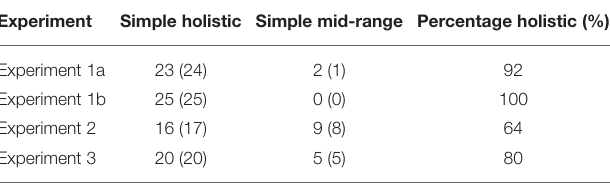
TABLE 2 | Number of participants (out of 25) classified as using the simple holistic vs. mid-range in their average estimations, in the four experiments based on BIC values.